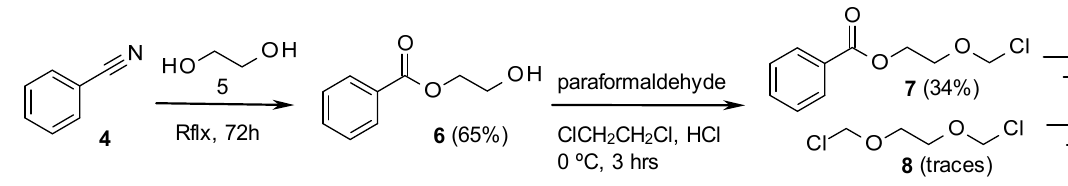
Scheme 1. Initial steps of the synthesis of